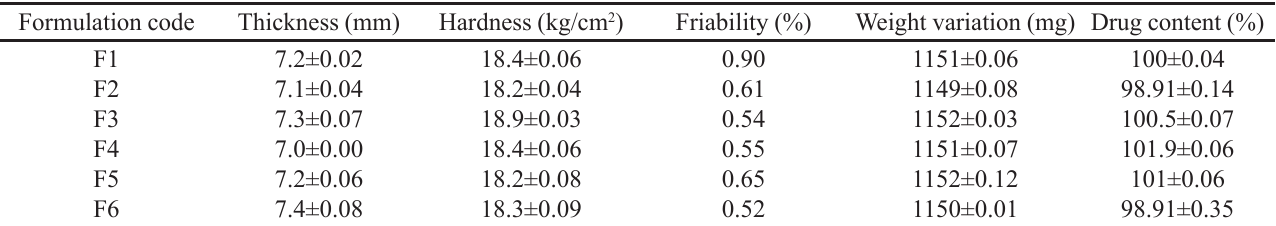
TABLE III - Technological characterization of sustained release tablets of AMT (Mean± S.D, n=6) Formulation